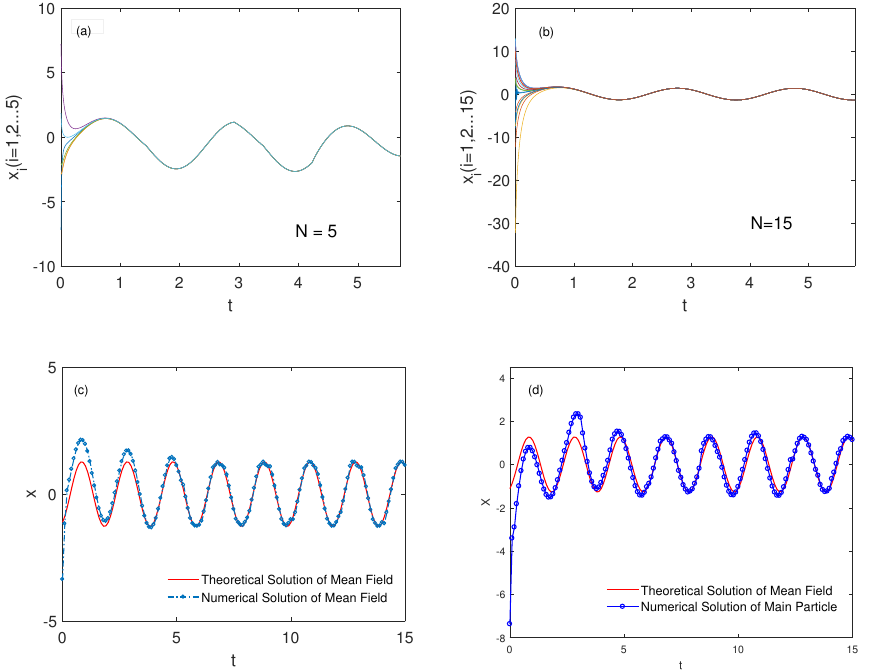
Figure 5. The time evolution trajectory of the steady-state output of the system. The parameters are set as α = 0.9, ω = 1, (cid:101) = 1, λ = 1, Ω = π , and σ 2 = 0.5 ω 2 + ωλ α . ( a ) The numerical simulations of the general particles vs. the theoretical result of the mean field, N = 5. ( b ) The numerical simulations of the general particles vs. the theoretical result of the mean field, N = 15. ( c ) The numerical and theoretical results of the mean field, N = 10. ( d ) The numerical simulation of the main particle vs. the theoretical result of the mean field, N =